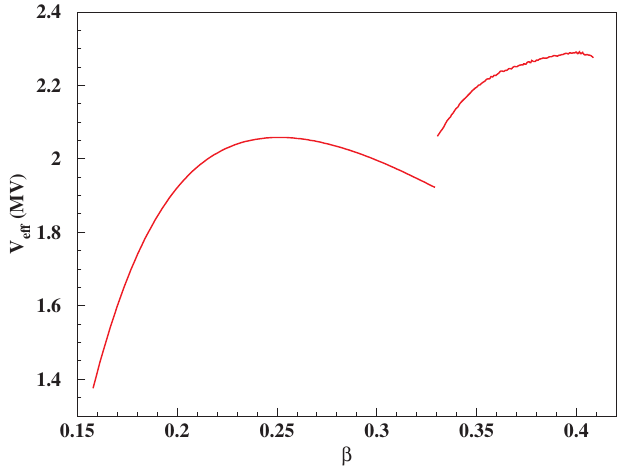
FIG. 2. (Color) The effective voltage as function of the incoming particle velocity for two cavity types used in the medium- (cid:1) section of the RIA driver linac.